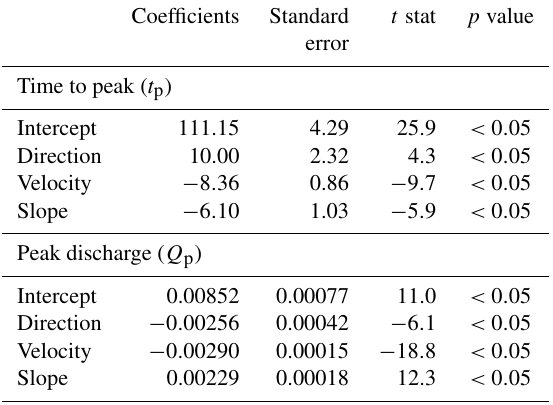
Table 4. Regression coefficients, standard error, the t statistic, and associated p value for multiple regression